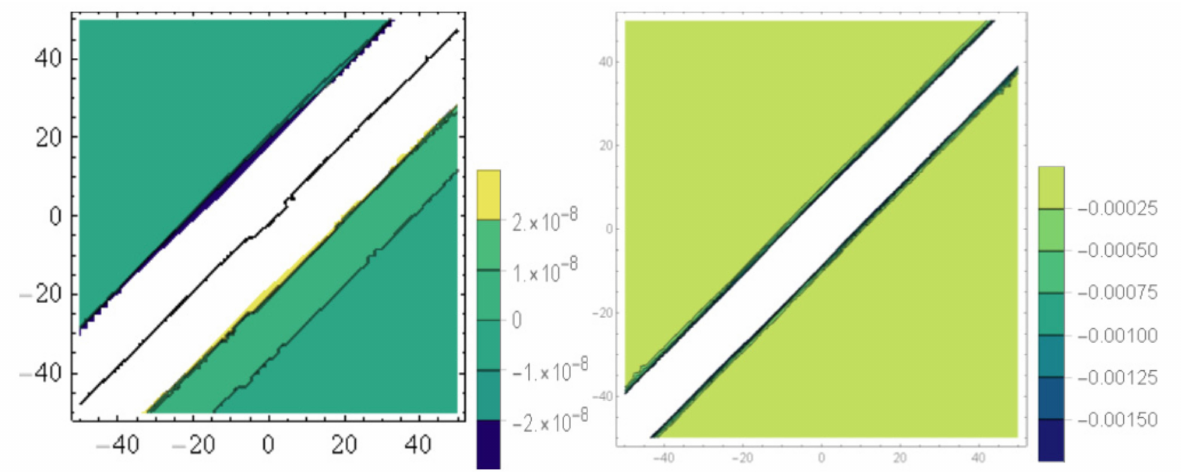
Figure 21. The contour surfaces of Equation (32) for ε = 0.4, α = 0.1, − 50 < x < 50, − 50 < t <